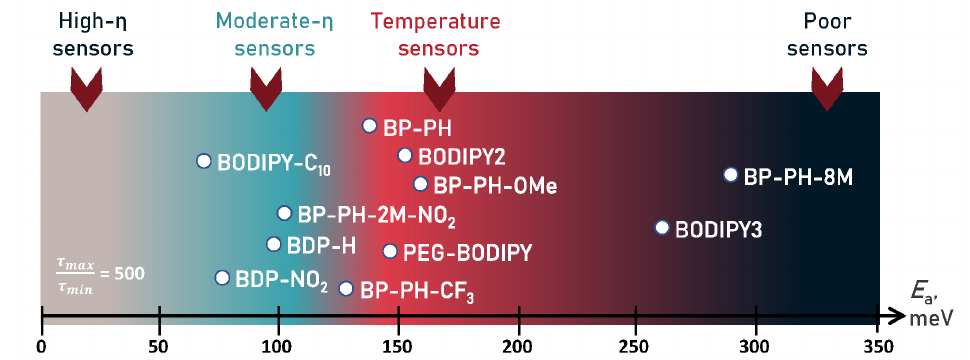
Figure 8. Visual scale demonstrating which energy barrier values are required for different types of sensors. From left: light grey—high-viscosity sensors, sky blue—moderate-viscosity sensors, red—temperature sensors, dark grey—poor sensors. White dots show energy barrier values of BODIPY derivatives reported in this paper (BP-PH-CF 3 , BP-PH-OMe, BP-PH-8M), together with the barriers for other derivatives reported by Toliautas et al. (BDP-H, BDP-NO 2 ) [41], Polita et al. (BODIPY-C 10 ) [47], Ogle et al. (PEG-BODIPY) [9], Maleckaite et al. (BP-PH, BP-PH-2M-NO 2 ) [33], and Vysniauskas et al. (BODIPY2, BODIPY3)